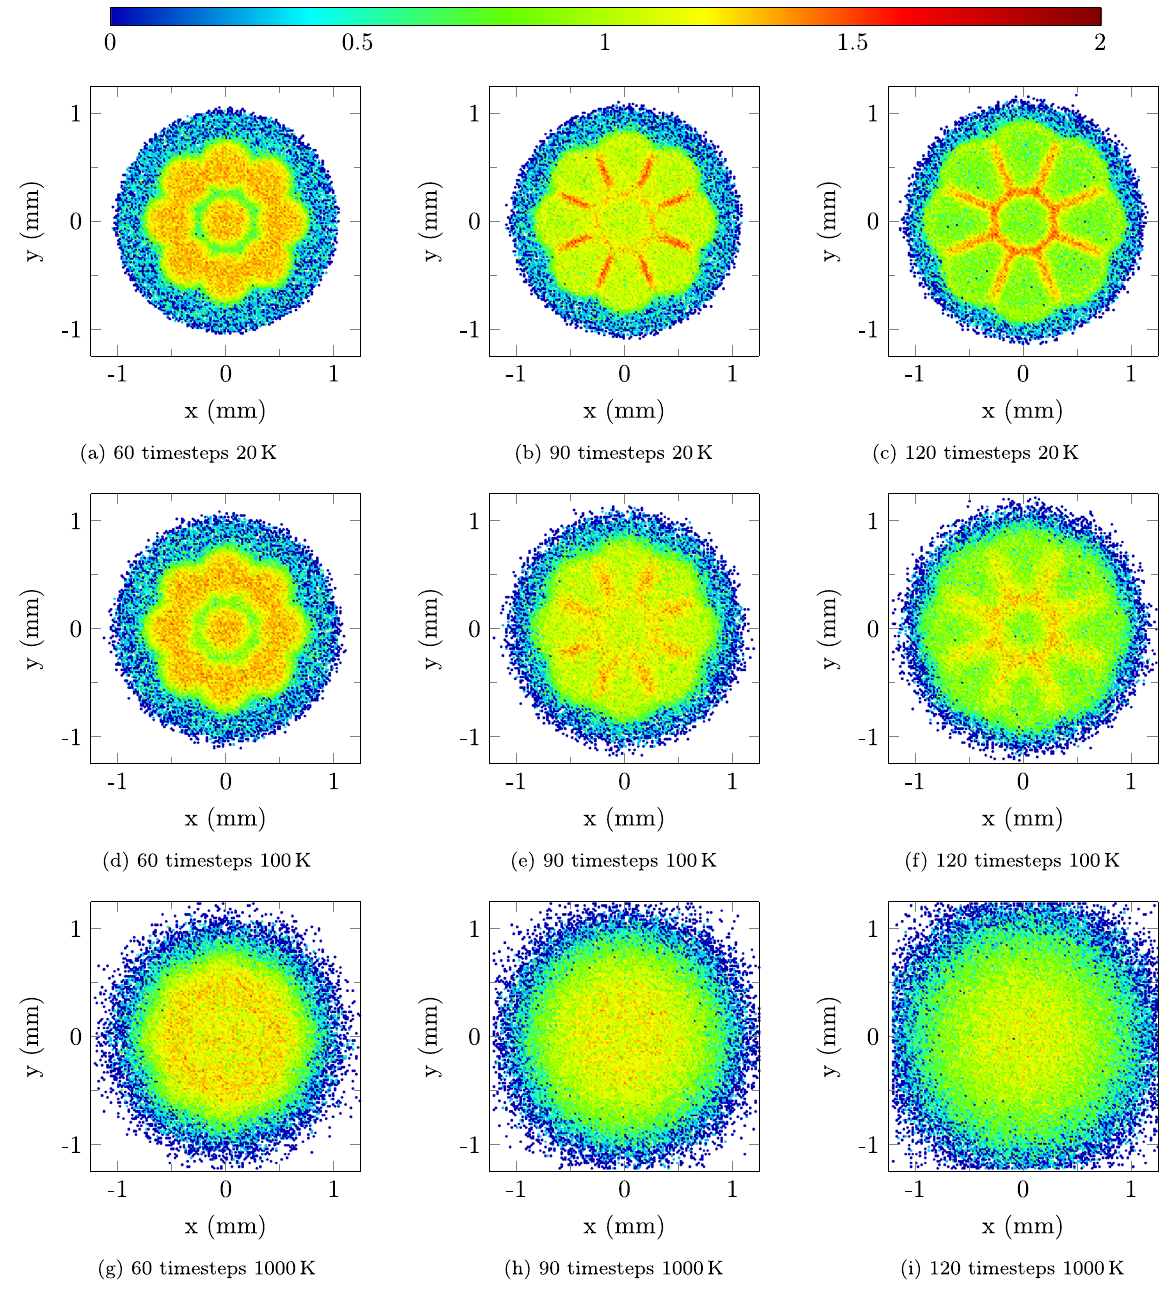
FIG. 12. Density log plots of the evolution of the electron beamlets with different initial temperatures: (a – c) 20 K, (d – f) 100 K, and (g – i) 1000 K. The simulations were performed by PHAD and different number of time steps are